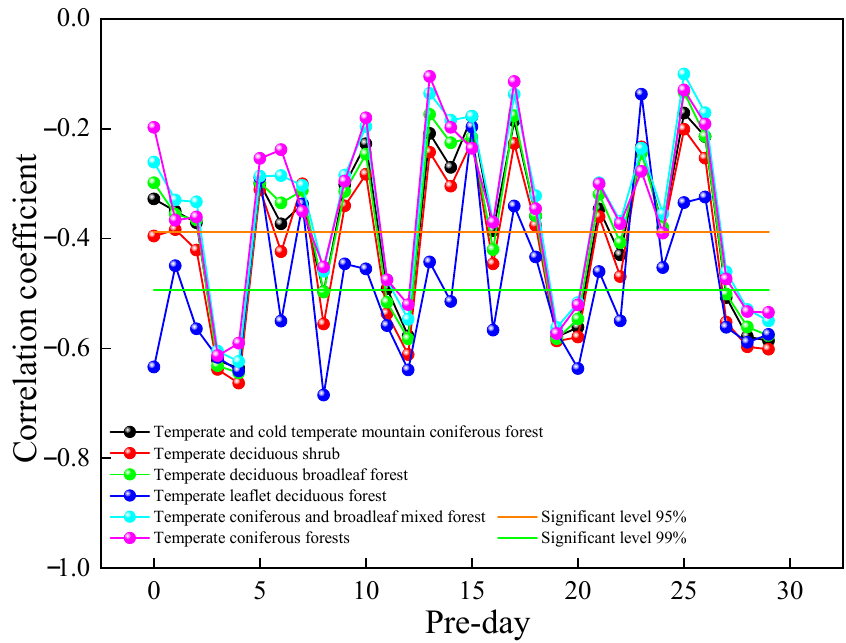
Figure 10. Relationship between GPP and urban air SO 2 concentration for the different vegetation types in 2019.